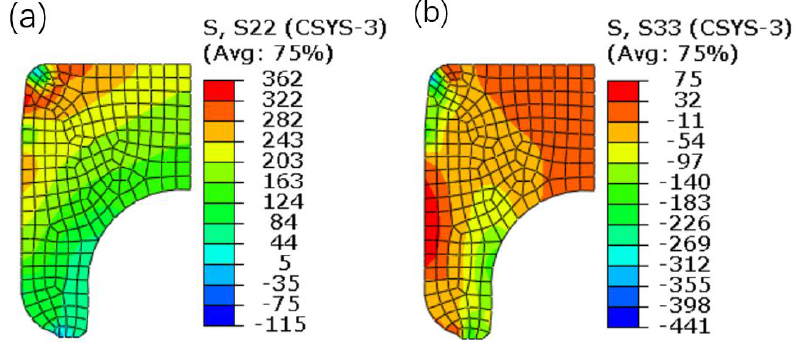
Figure 20. Stress contour plots of the inner ring. ( a ) Circumferential stress. ( b ) Axial stress.